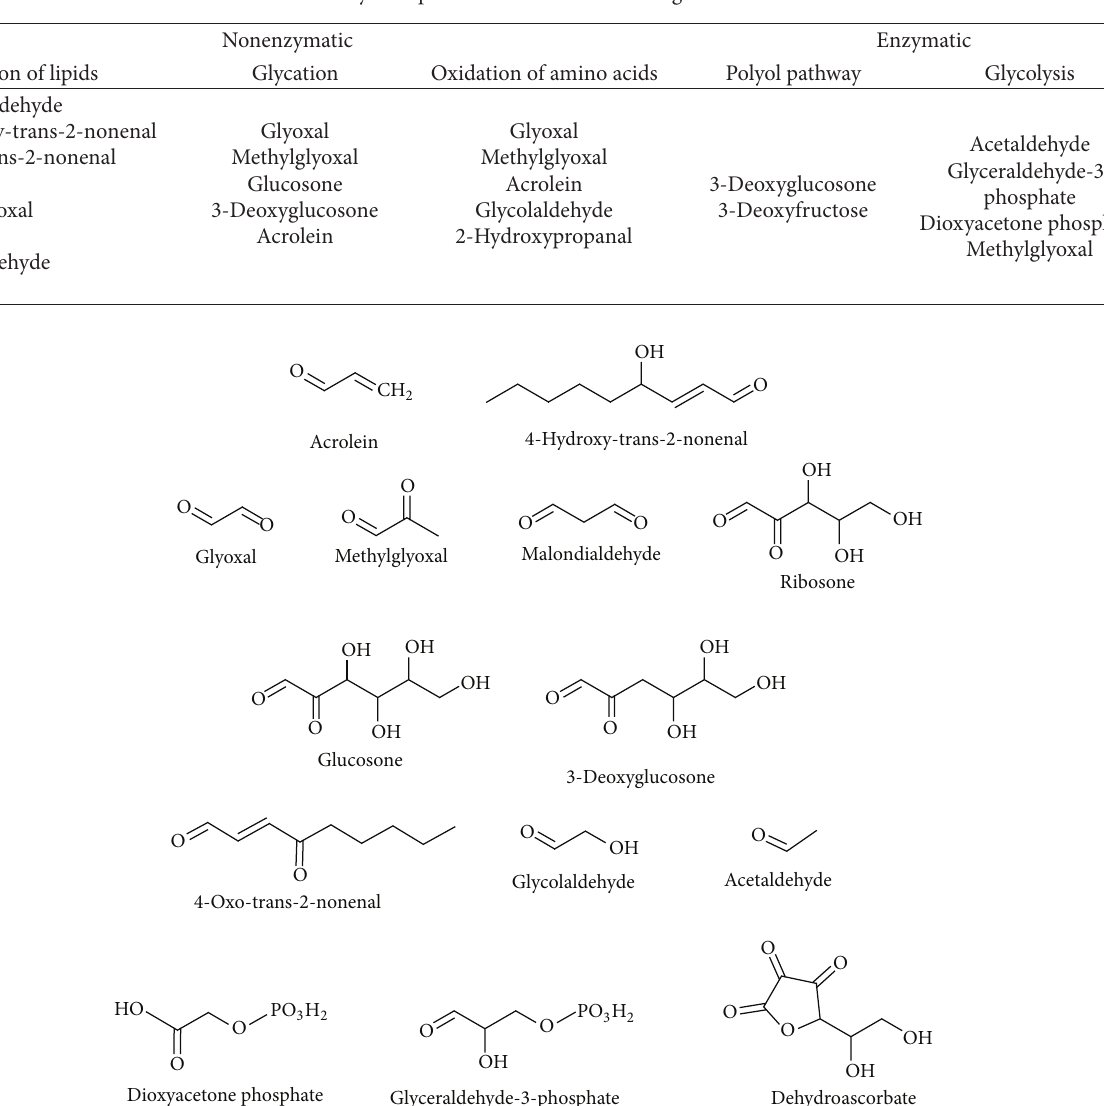
Table 1: Carbonyl compounds and sources of their generation in vivo .